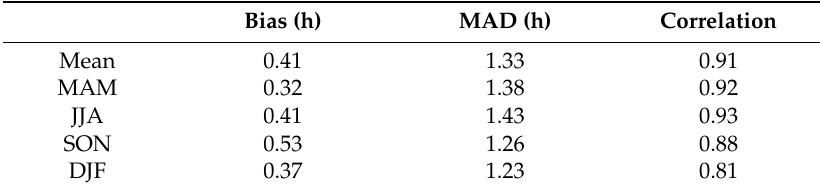
Table 1. Bias, MAD and correlation for the comparison of daily SDU and ECA&D for the time period